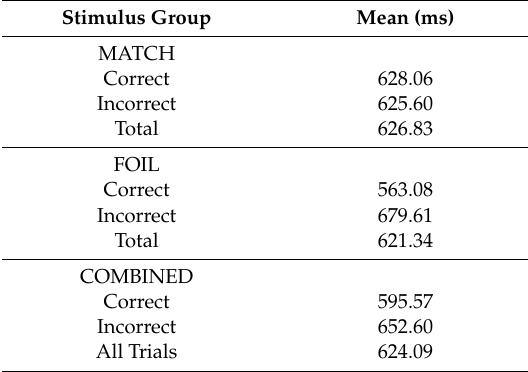
Table 5. E ff ect of Response Strategy and Stimulus Type on Reaction Times for the Simulated Malingering Condition in Experiment 2 ( N = 15) grouped by Stimulus Type.